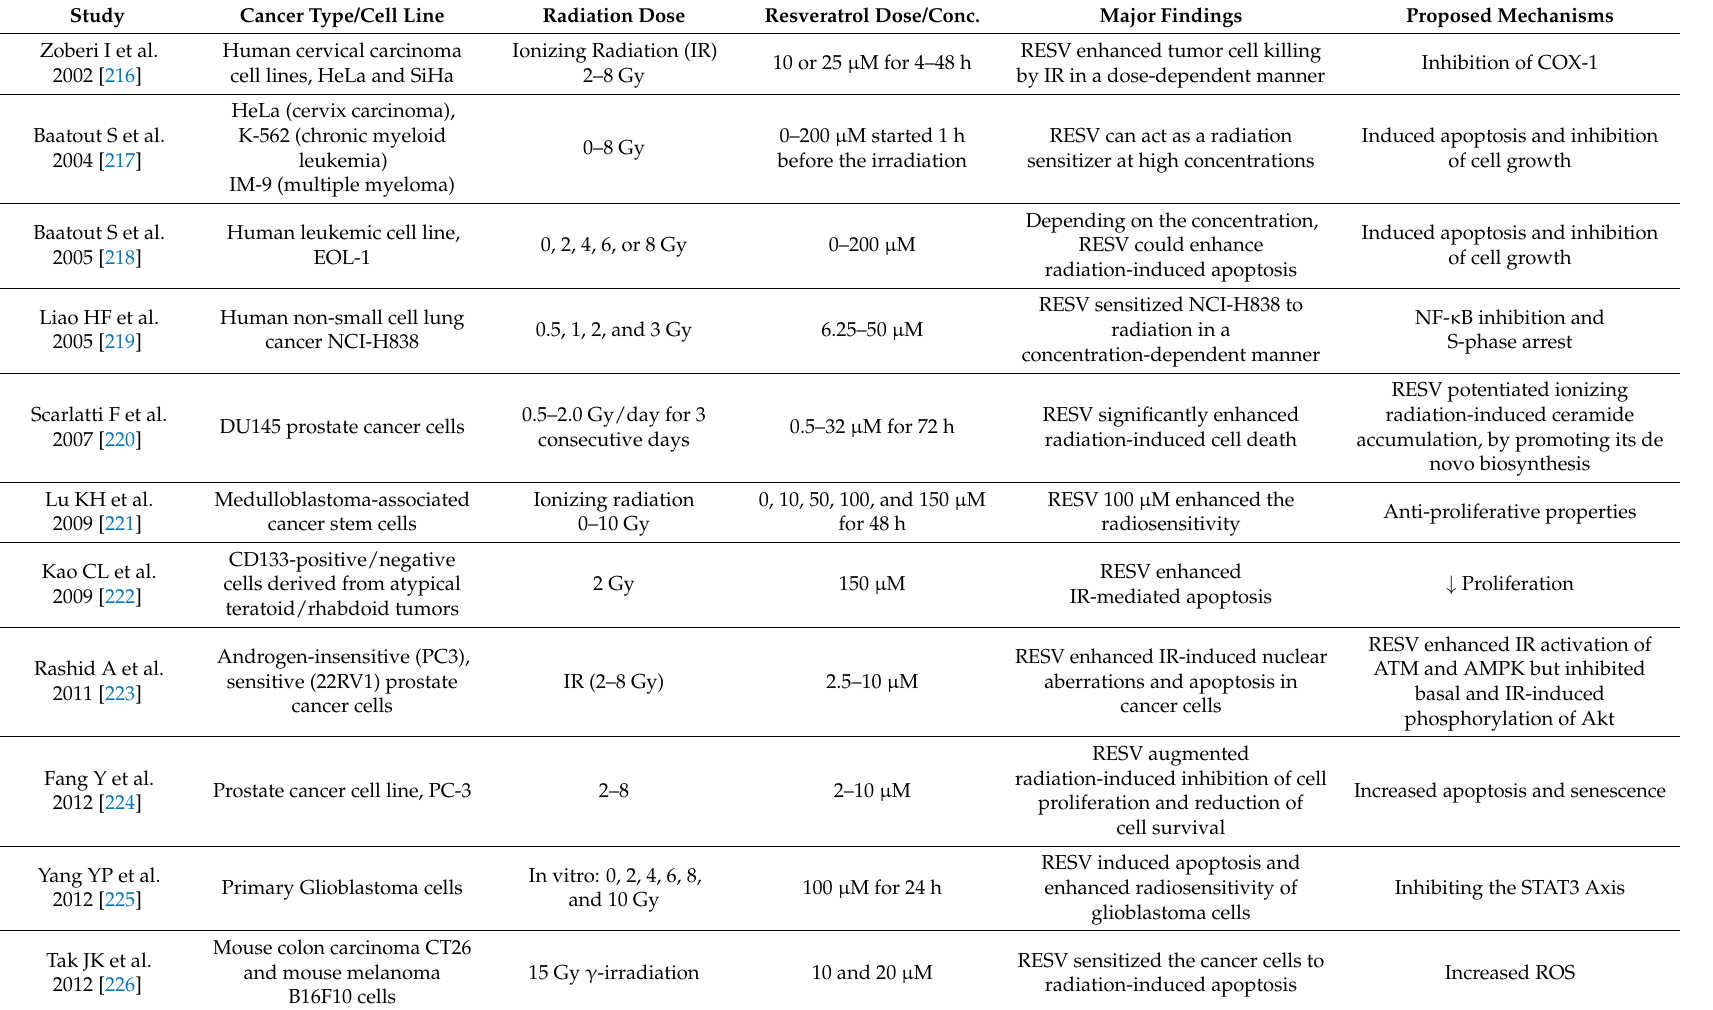
Table 5. Studies demonstrating the radiomodulatory effects of